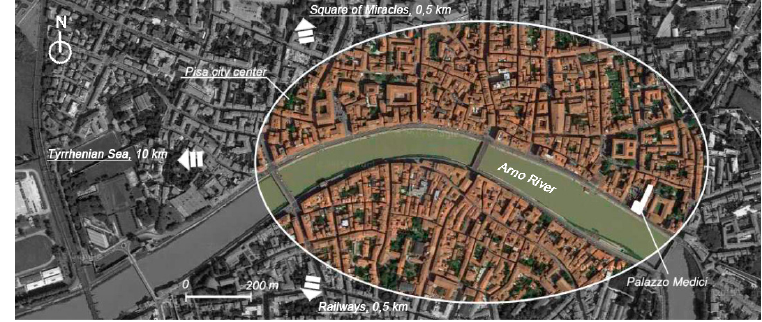
Figure 1. Aerial view of Pisa with positioning of Palazzo Medici .